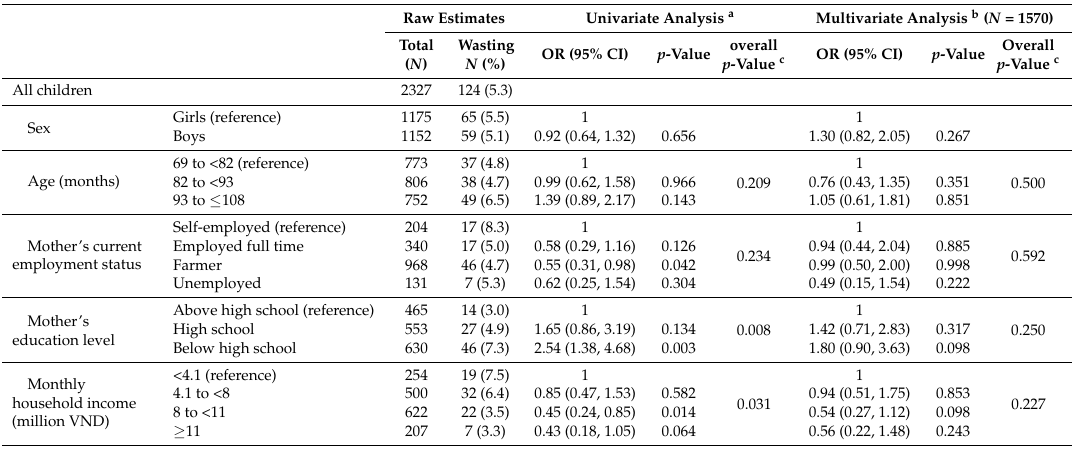
Table 4. Prevalence of wasting (BMI-for-age z -score < − 2) and associated sociodemographic factors in 6–9-year-old children in rural areas of